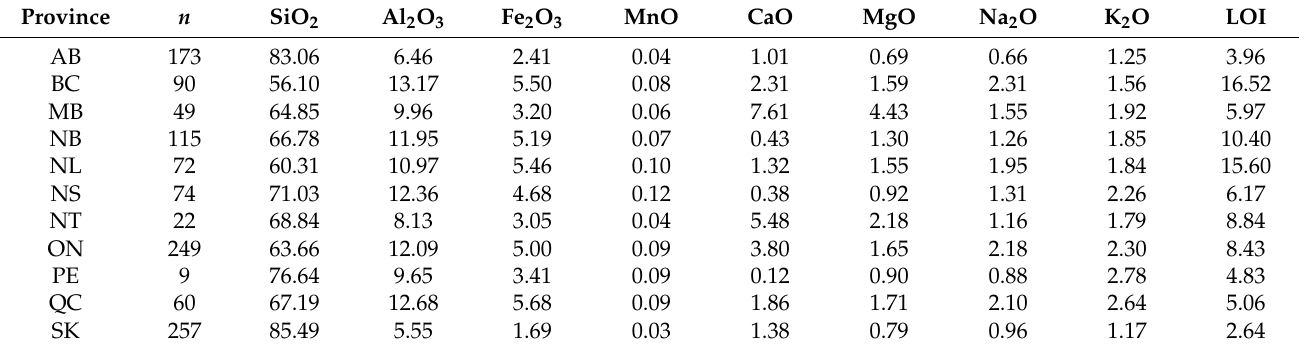
Table 2. Number of sites ( n ), mean soil oxide content (wt%), and loss on ignition (LOI in %)